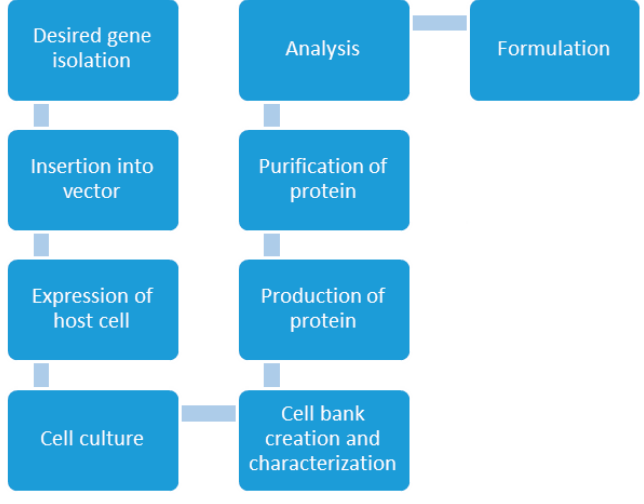
Figure 2. Conventional preparation process of biologics [13].